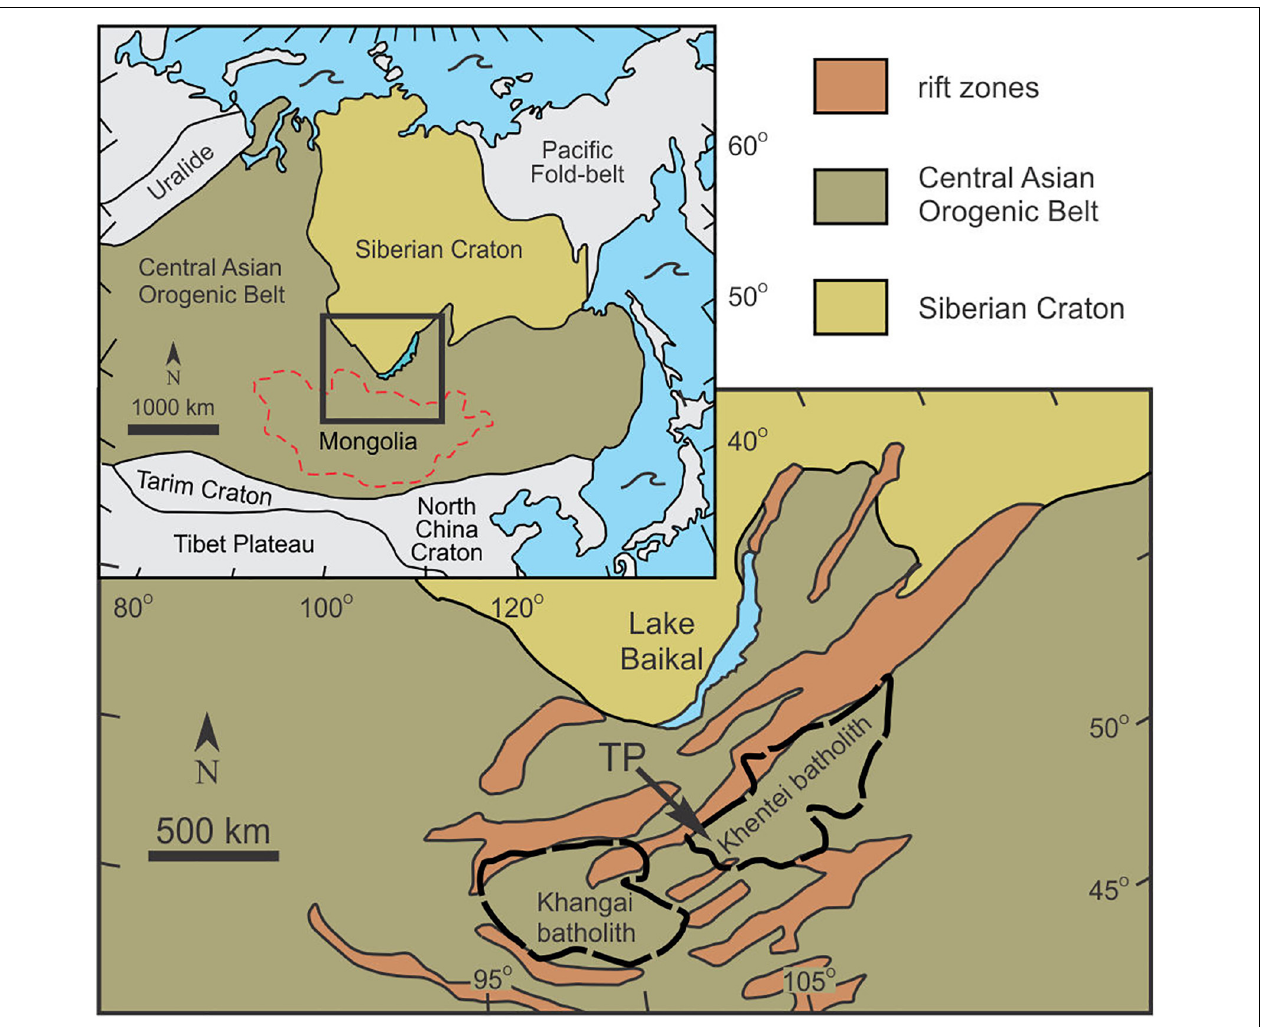
FIGURE 1 | Simplified geologic map of parts of the Central Asian Orogenic Belt and Siberian Craton showing the occurrence of two Late Paleozoic–Early Mesozoic batholiths and rift zones (modified after Yarmolyuk and Kuzmin, 2011) and the Tukham pluton (TP). Inset is a sketch map of the Central Asian Orogenic Belt, Siberian Craton, and surrounding geological provinces (modified after Jahn et al., 2009) showing the location of Figure 1